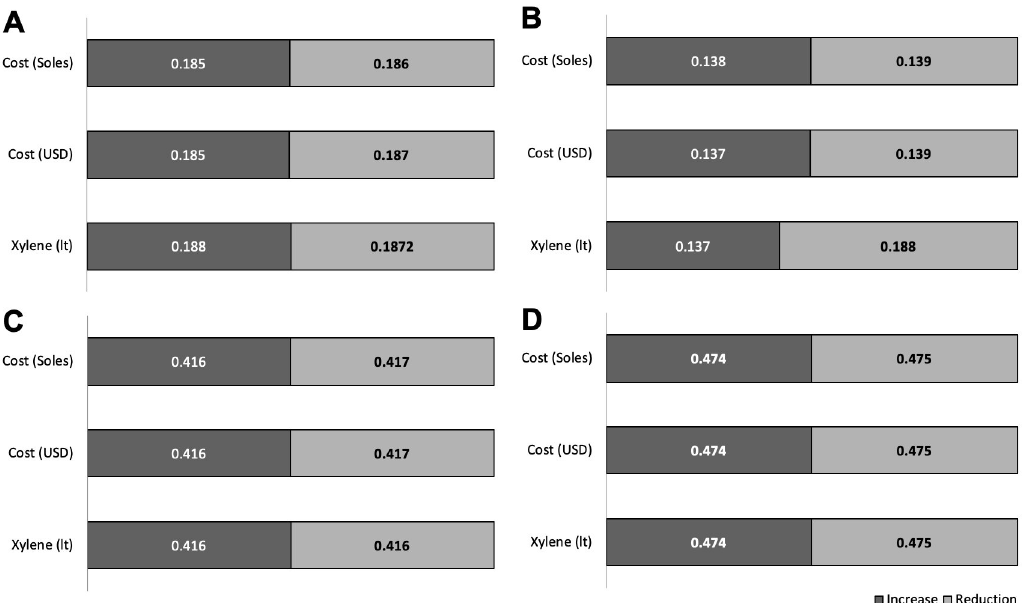
Figure 4. Increase or reduction (in liters and costs) of xylene in four EsSalud hospitals with the use of three xylene-baths in Pap staining. A. Hospital Nacional Guillermo Almenara Irigoyen, B. Hospital Nacional